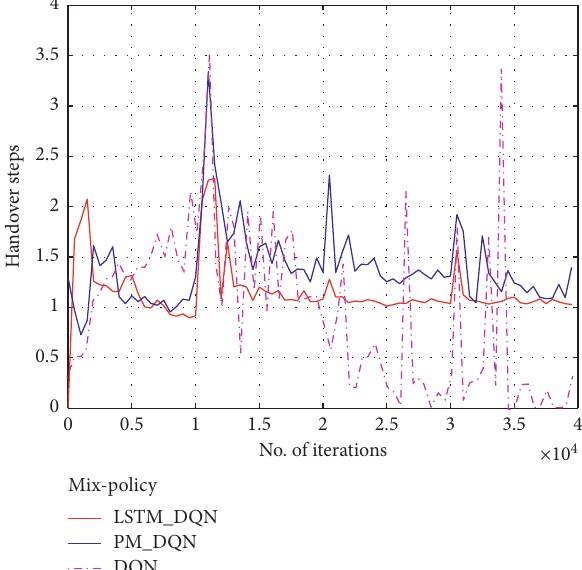
Figure 12: Relationship between the number of iterations and handover steps (mix-policy).